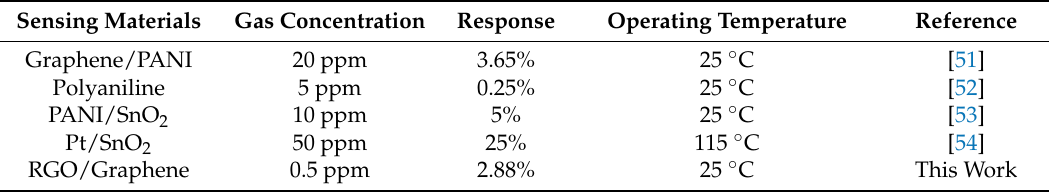
Table 4. Comparison of various indicators between different ammonia